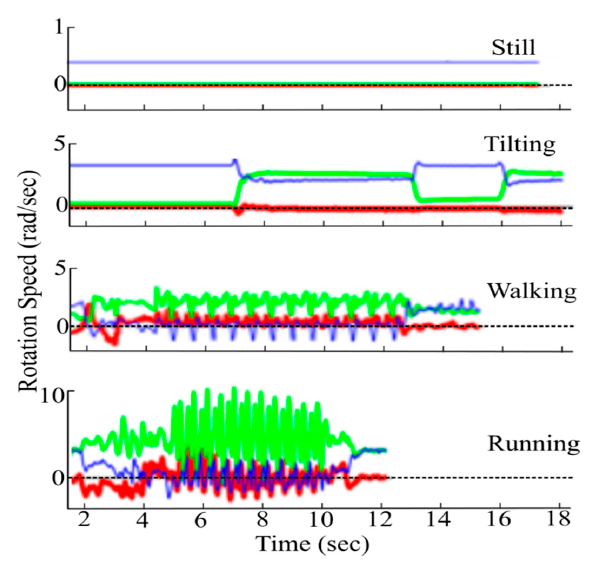
Figure 11. Test case three-axis outputs for various activities. Table 1. Comparison of the proposed system with existing systems.